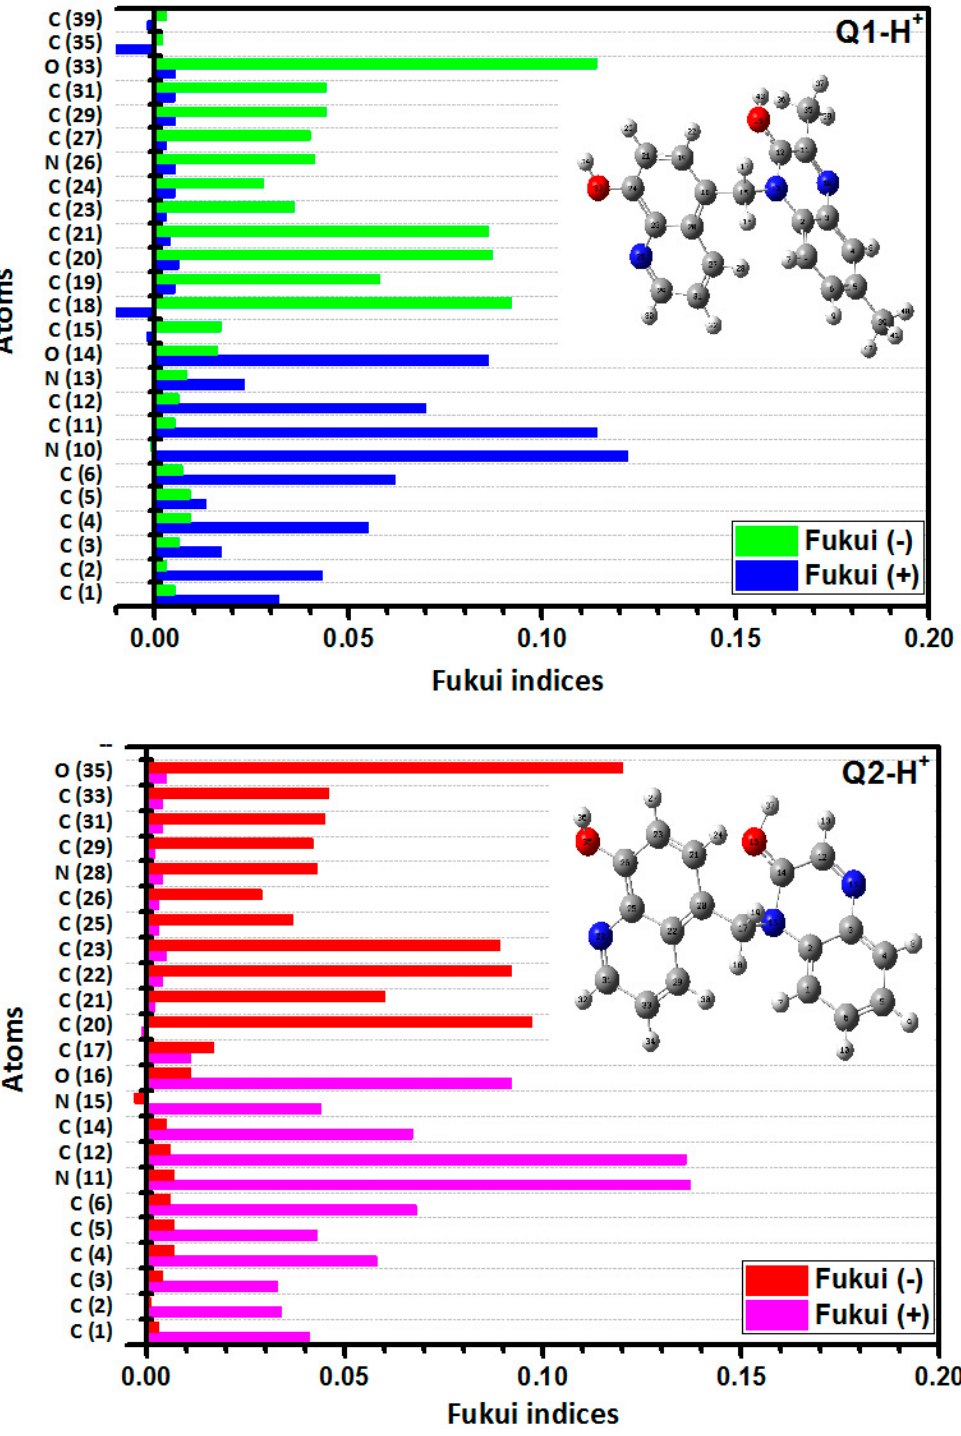
Figure 8. Graphical illustration of the Fukui function indices for selected atoms in the investigated inhibitors in their protonated forms. The optimized structures of the molecules are superimposed in the figure.